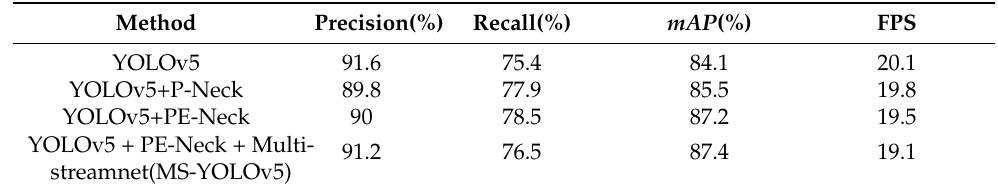
Table 2. Performance comparsion of various method.